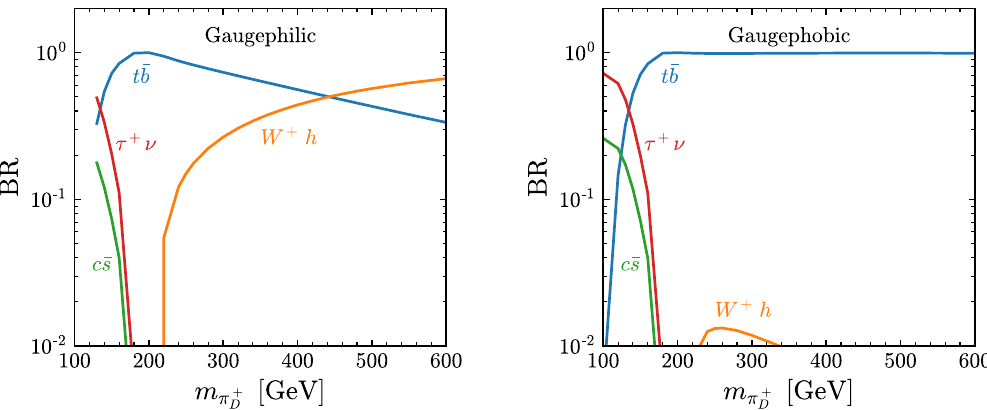
Figure 2 . Branching ratios of the charged pions.